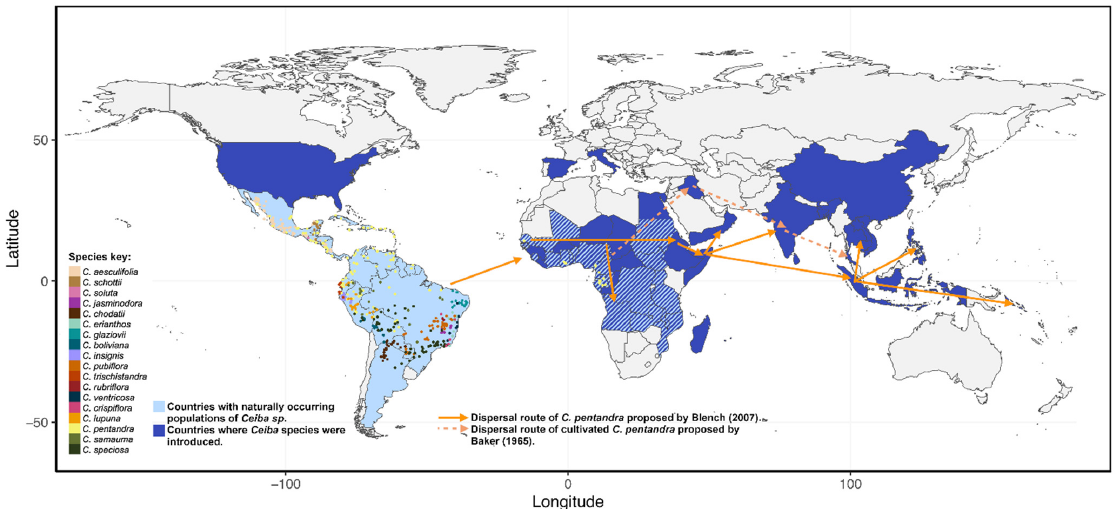
Figure 3. Distribution of the 18 recognized Ceiba species, and proposed routes of human-facilitated dispersion of C. pentandra . The dots represent the data of naturally-occurring specimens, adapted from Dick et al. [42] and Pezzini et al. [13]. Countries with both light and dark blue lines in Africa represent those countries where there are mixed reports of both natural populations of C. pentandra and assisted introductions. Dispersal routes towards Asia were adapted from Blench [8]. Data on assisted introductions was compiled from several sources, primarily [73,74].